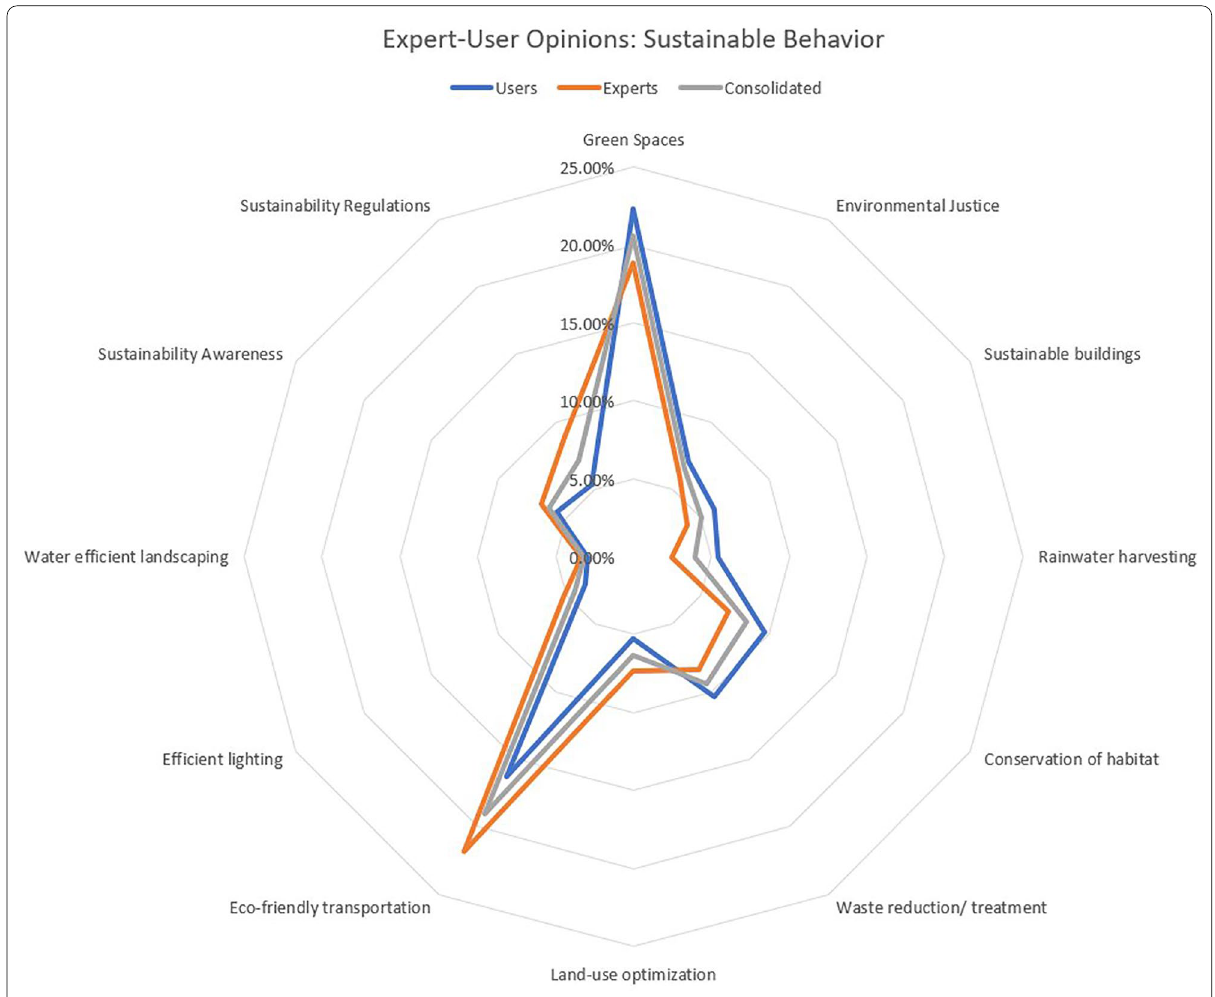
Fig. 9 Comparison between experts and users’ opinions—sustainable behavior category